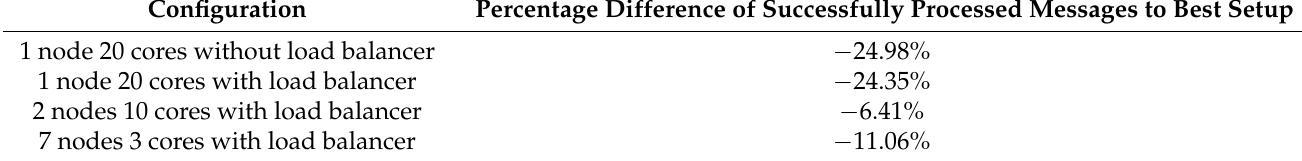
Table 2. Percentage difference at optimal load